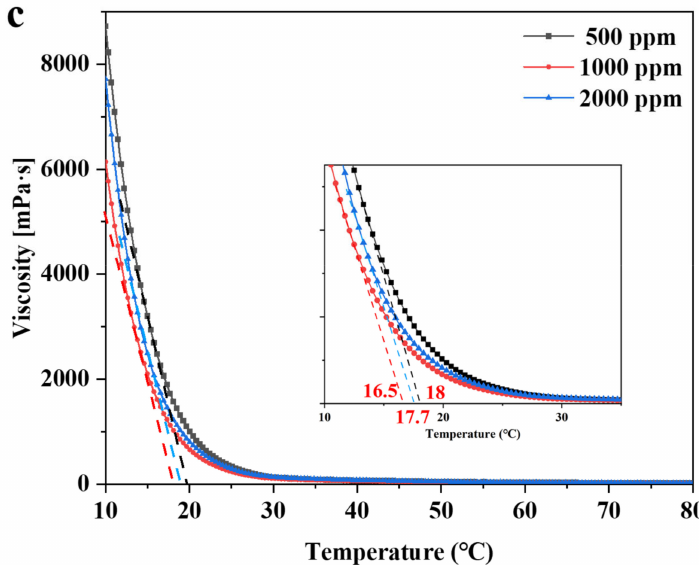
Figure 11. Effect of bipolymers on the viscose–temperature property of an African crude oil in the presence of different bipolymers at ( a ) 250 ppm and ( b ) 1000 ppm. ( c ) TDA2024-22 at vary- ing